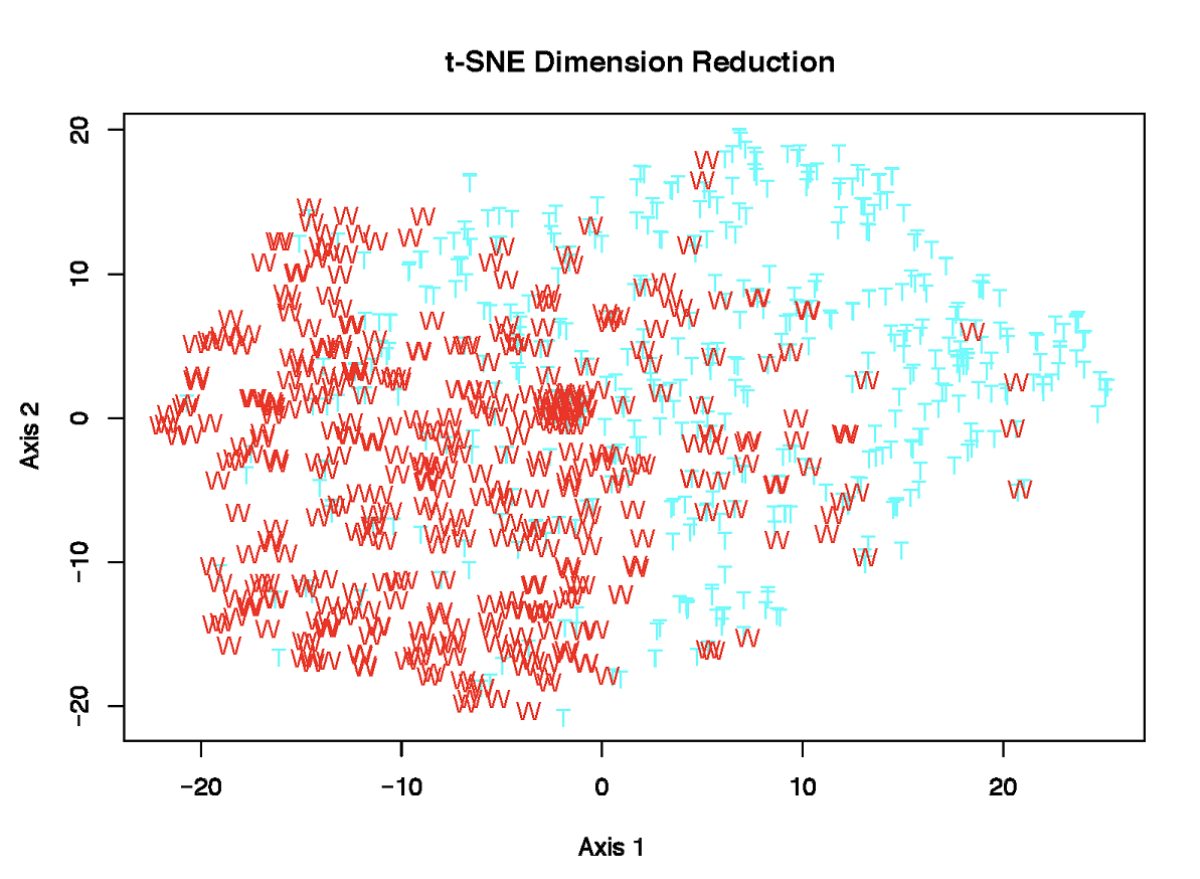
Figure 4. t -SNE results for viral COVID-19 tweets (T) and Weibo posts (W).